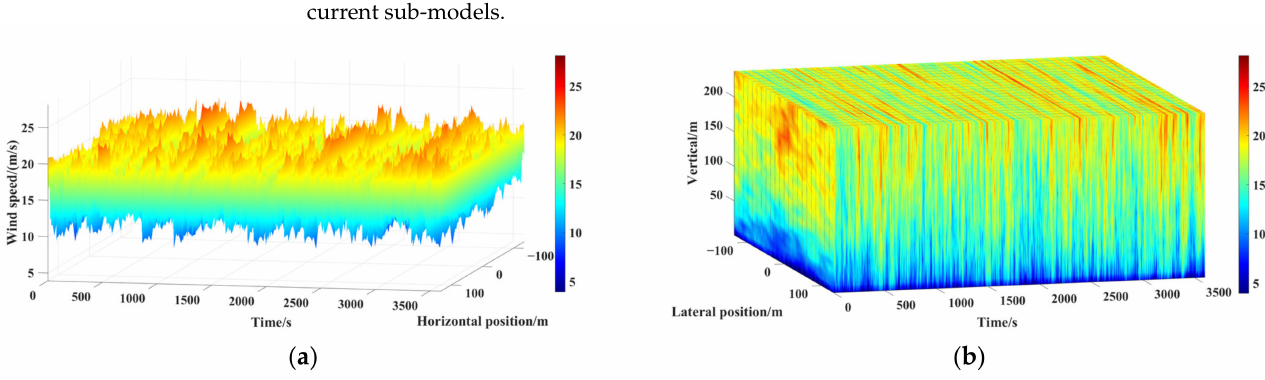
Figure 9. The turbulence wind generated in TurbSim: ( a ) Wind speed in hub height; ( b ) wind speed distributed over the whole wind